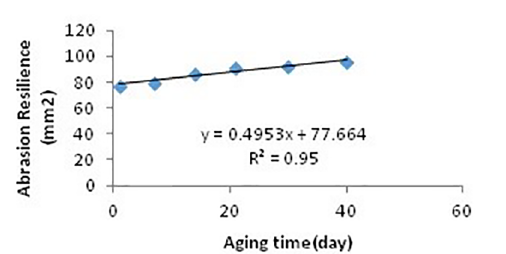
Figure 10. Abrasion resilience vs. Aging